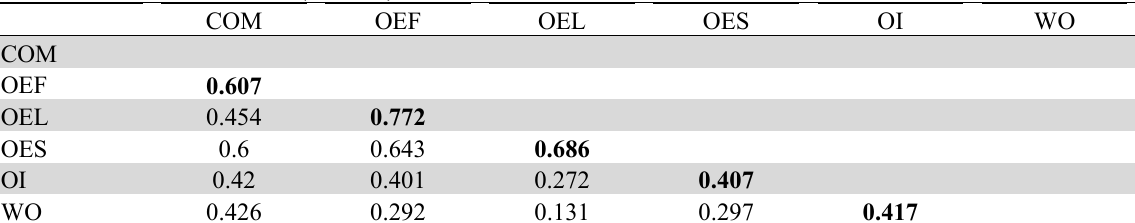
Heterotrait-Monotrait Ratio (HTMT)